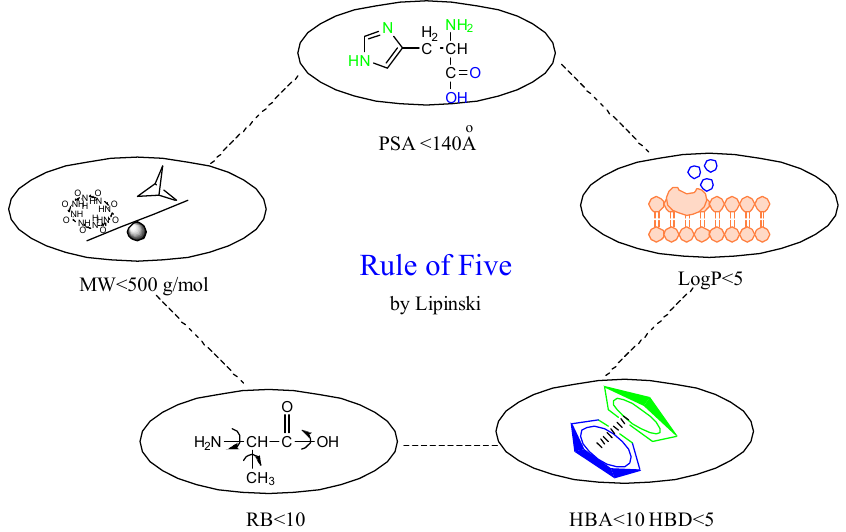
Figure 1. The visual interpretation of Lipinski’s rule of five criteria.